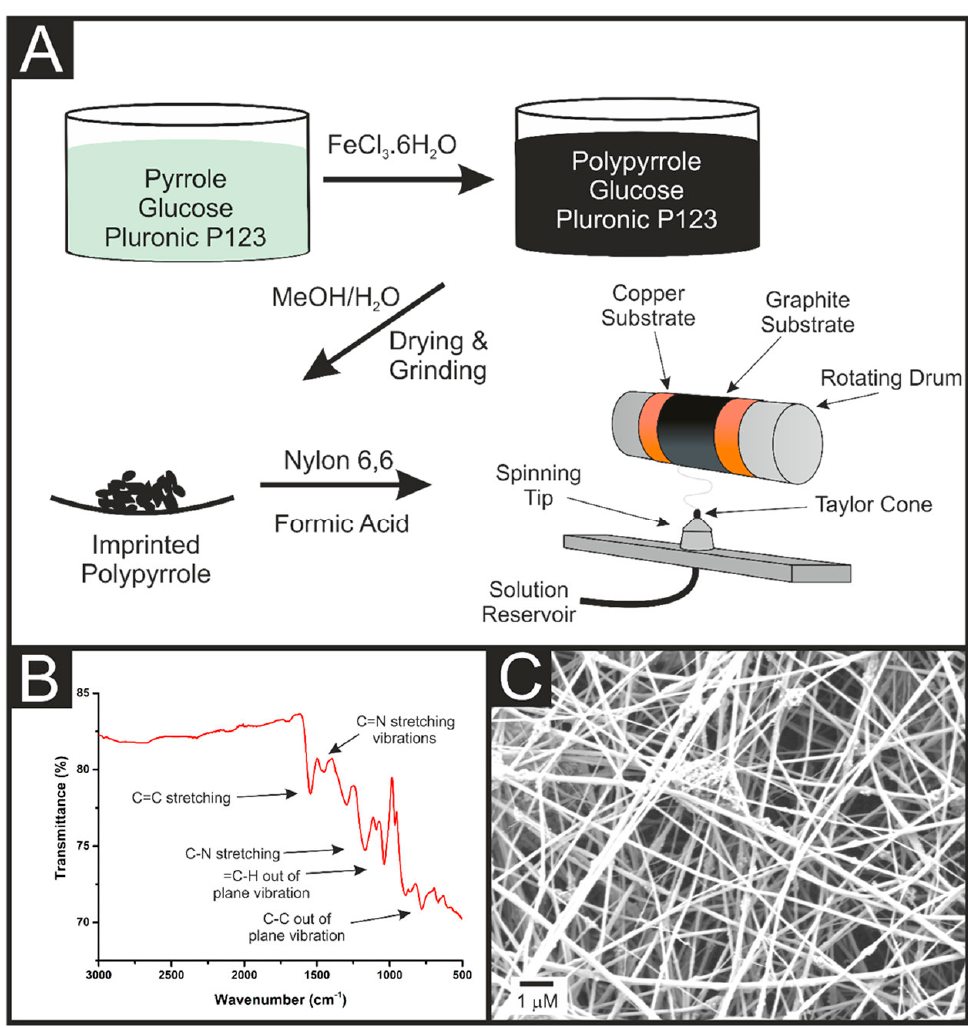
Figure 5. ( A ) Illustration of the production of electrospun MIP sensors. ( B ) FT − IR analysis of the polypyrrole MIP. ( C ) Image of electrospun nylon fibers embedded with PPy MIPs for the detection of glucose. Figure reproduced with permission from ref. [77]. Copyright 2021, American Chemical Society.